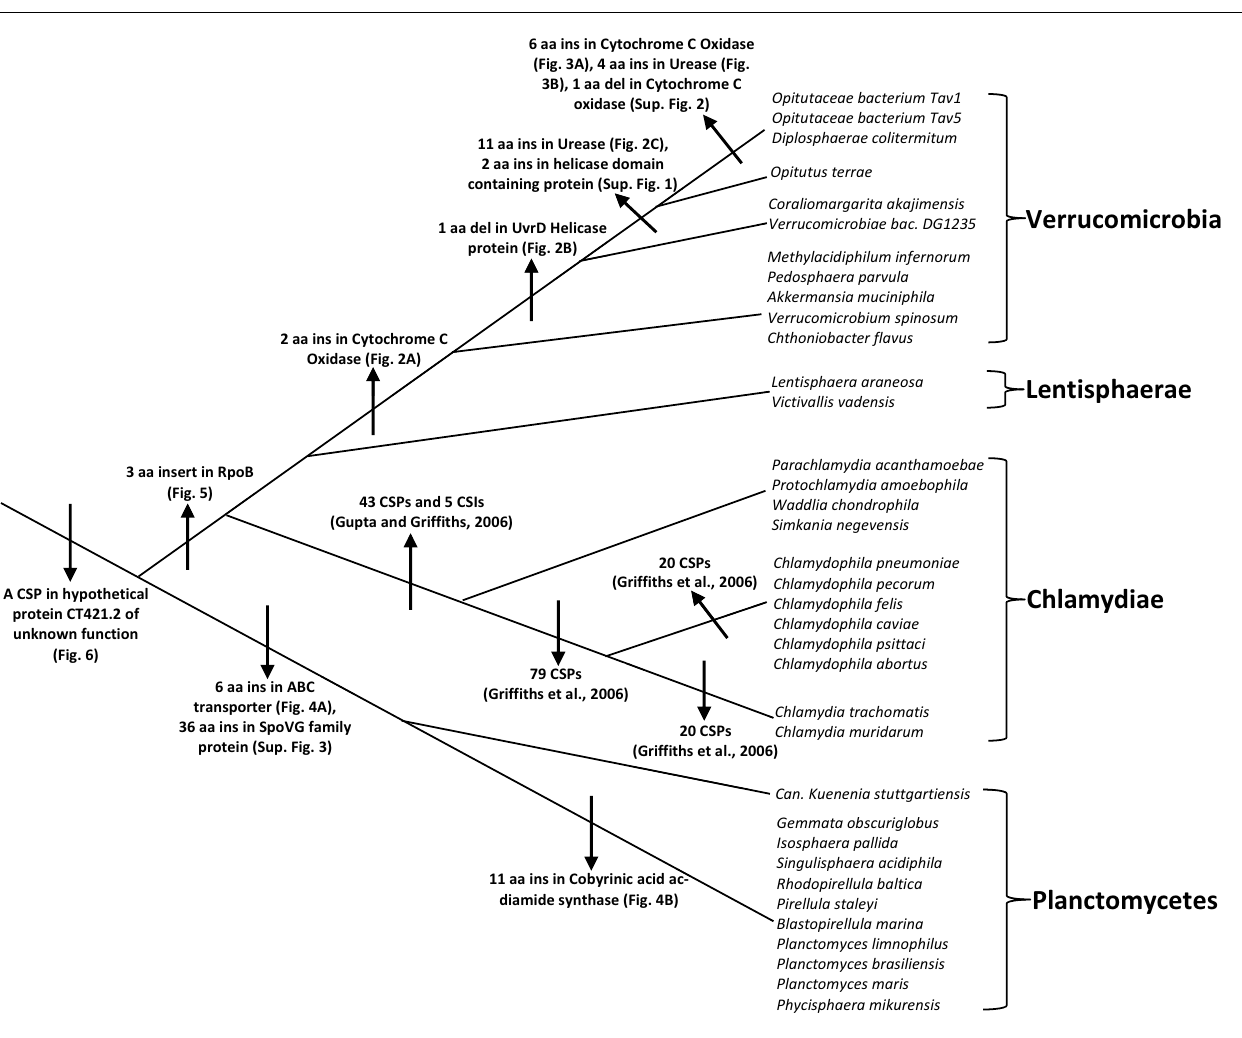
molecular signatures likely originated. Information for various CSIs and CSPs for the Chlamydiae is from our earlier work (Griffiths et al., 2005; Gupta and Griffiths, 2006; Griffiths and Gupta,